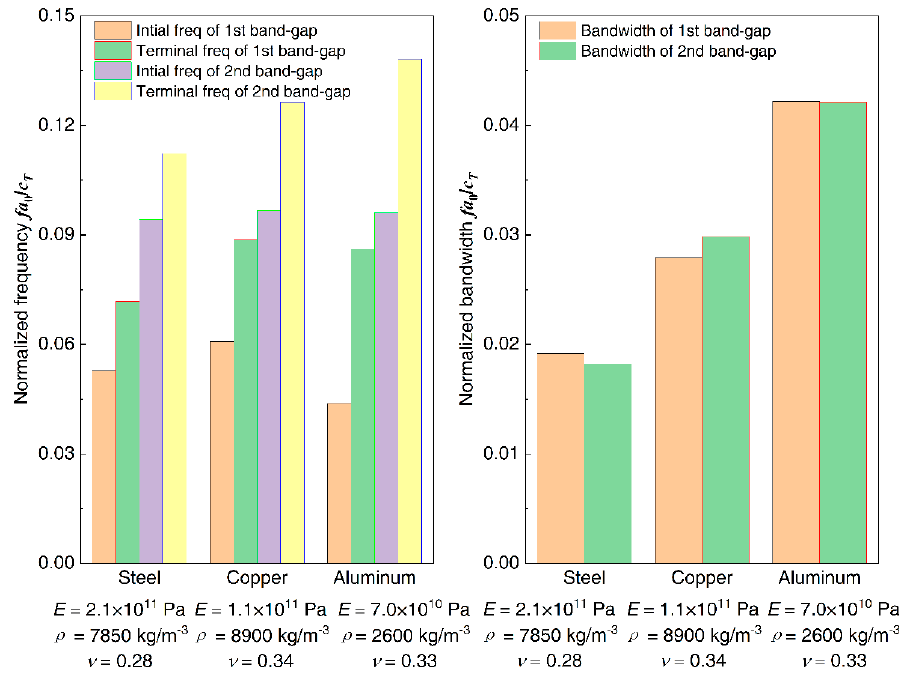
Figure 14. The influence of the material properties on band gaps.